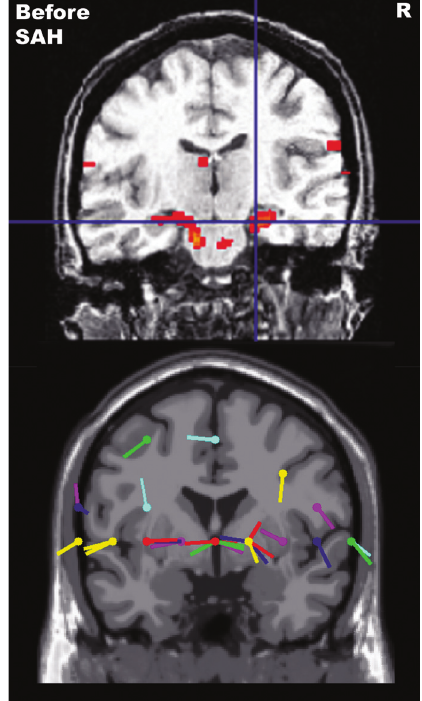
Figure 2. Coronal view of blood oxygen level-dependent (BOLD) activation responses (upper part) and dipole distribution (lower part). BOLD responses are localized in both hippocampi with a right-sided predominance when using only bilateral interictal epi- leptiform discharges (IEDs) to create the activation map. The same bilateral IEDs give rise to a spread distribution of dipoles to independent component analysis (inferior view), with six dipoles (~22%) located near the right hippocampus region. Each dipole color indicates an individual independent component analysis. SAH = selective